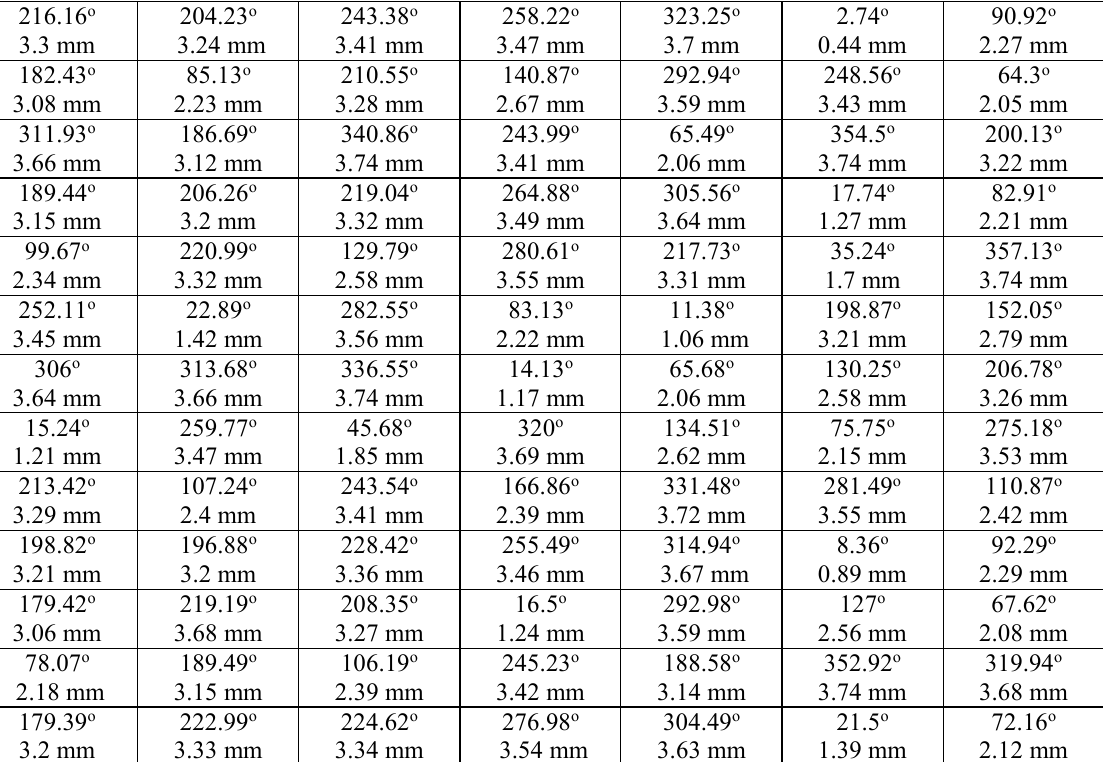
Table 4: The phase shift and the corresponding hole radius for dual beam transmitarray (first